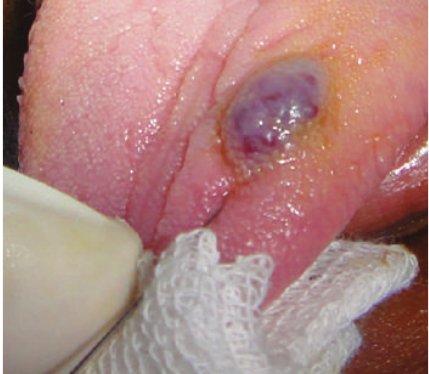
Figure 2: Administration of sclerosing agent.